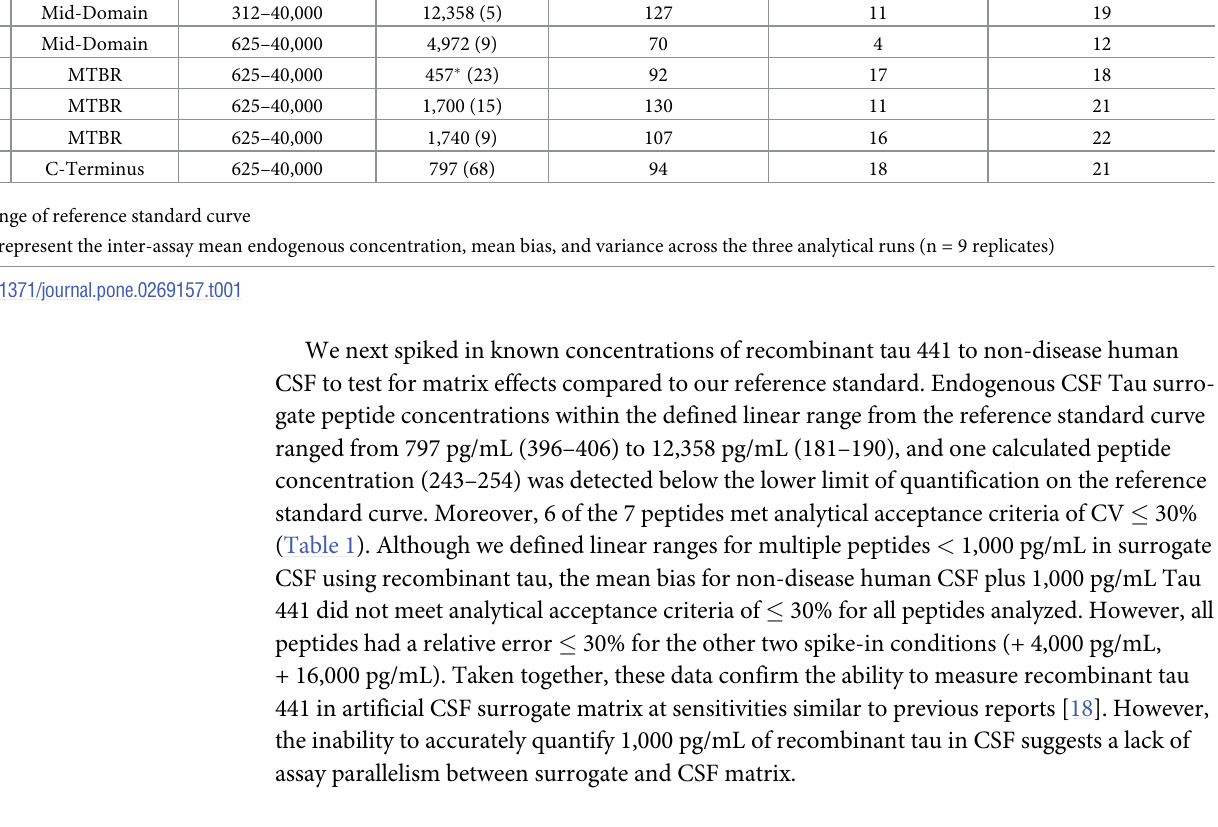
Table 1. Tau LC-MS accuracy and precision validation using recombinant tau 441 in non-disease CSF.